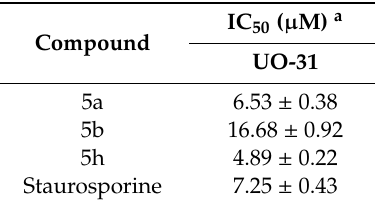
Table 3. In vitro anti-proliferative activity of diamide-based benzenesulfonamides 5a, 5b and 5h against renal UO-31 cancer cell line.